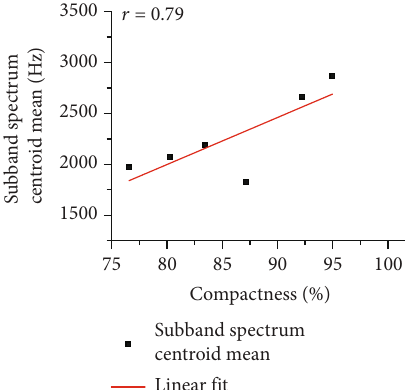
Figure 18: Correlation diagram of the mean value of the centroid of the subband spectrum and the soil mass with di ff erent compaction degrees under the action of 65(L) N hammering